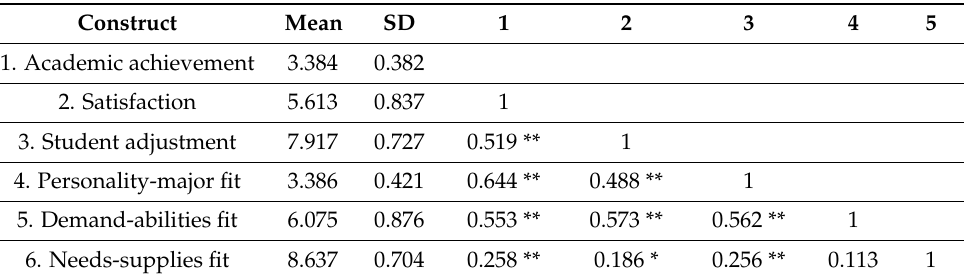
Table 2. Descriptive statistics and bivariate